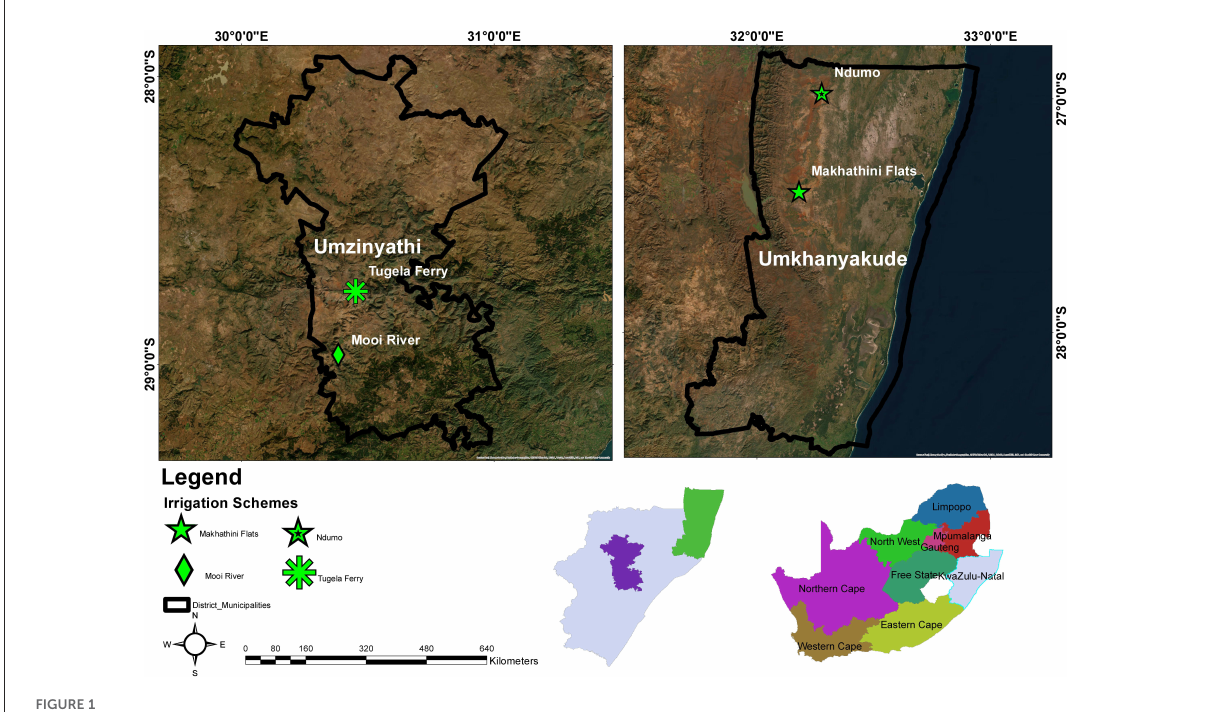
FIGURE1 Map of KwaZulu-Natal Province, South